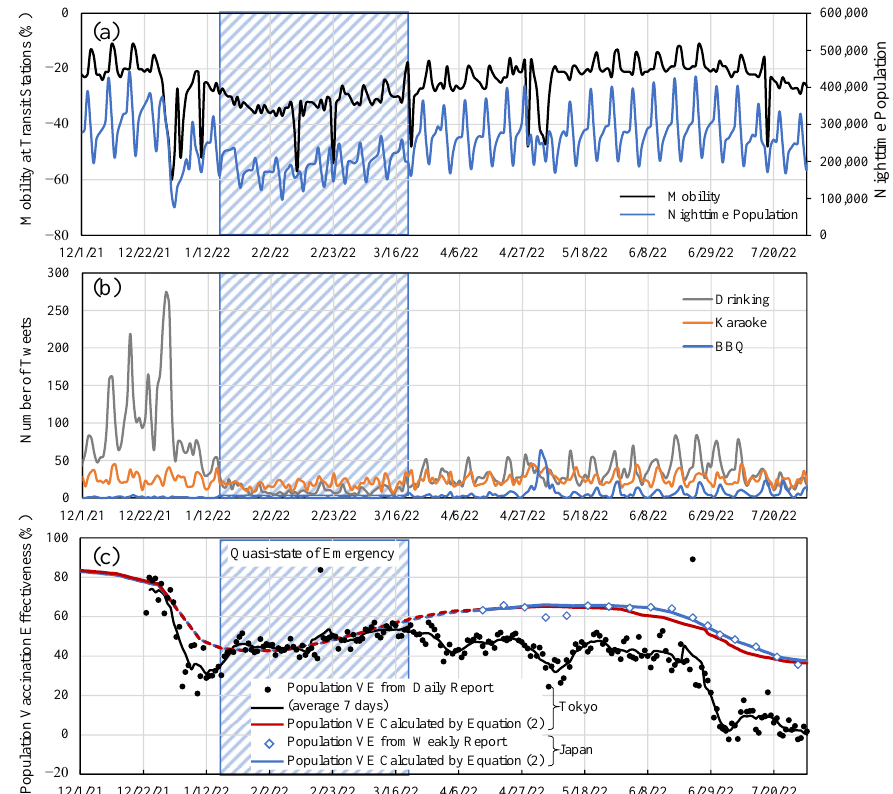
Figure 2. Time course of ( a ) mobility at transit stations and nighttime population volume in down- town area of Tokyo, ( b ) the number of tweets for social drinking and BBQ, and ( c ) Population VE estimated from daily report in Tokyo (dashed lines) and that weekly reported over Japan (solid lines).